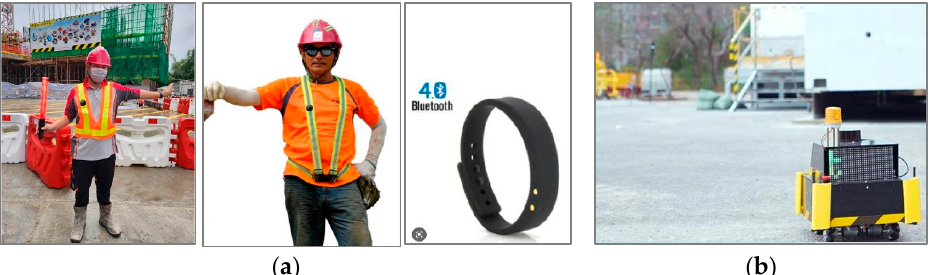
Figure 2. Use of Smart Technology in Enhancing Safety and Traceability at MiC Construction Sites (BEANiE 5.0). ( a ) High visibility safety vest, safety elastic vest, safety helmet or wristband with Bluetooth token; ( b ) MobiLog in operation.